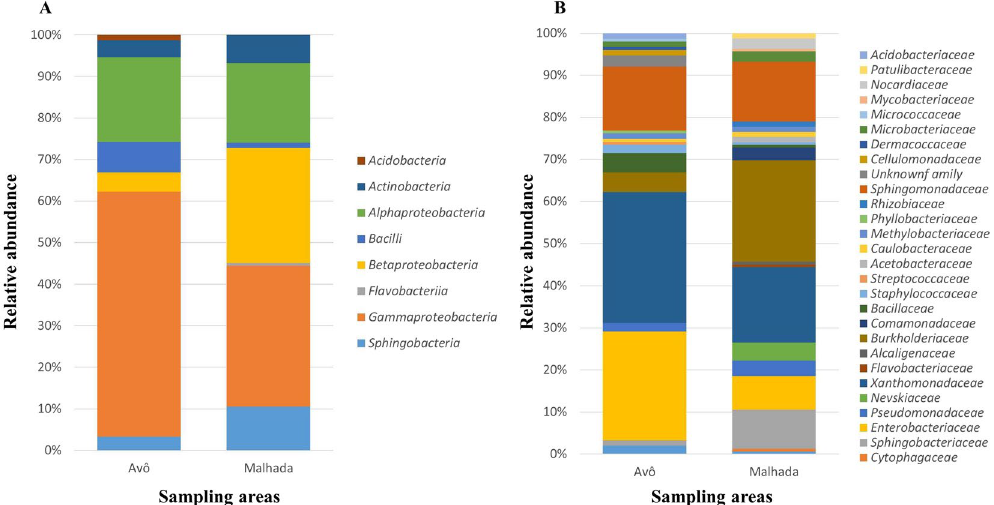
Figure 5. Phylogenetic characterization of endophytic, wood colonizing bacteria from pine trees of the two study sites (A and M) obtained by cultivation based approaches at the level of phyla ( A ) and families ( B